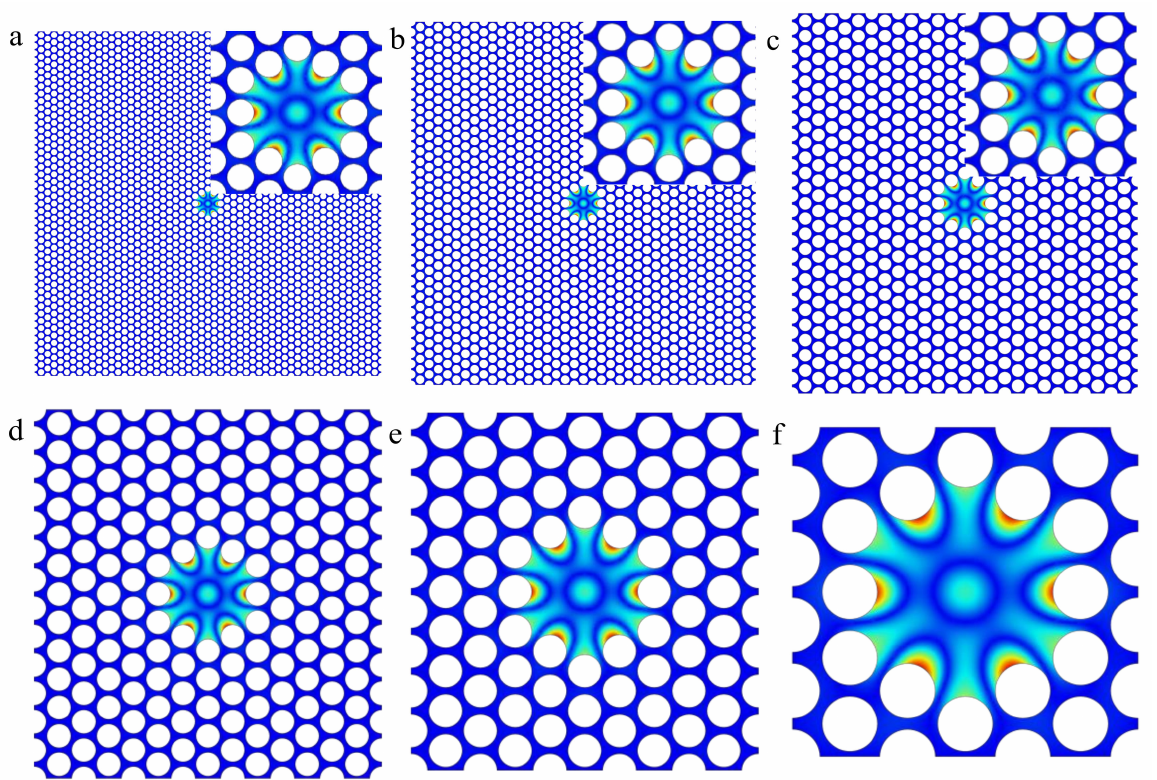
Figure 4. ( a – f ), The first defect mode shapes correspond to Figure 3a–f, respectively. Their out-of- plane displacements are approximately in the same vibration